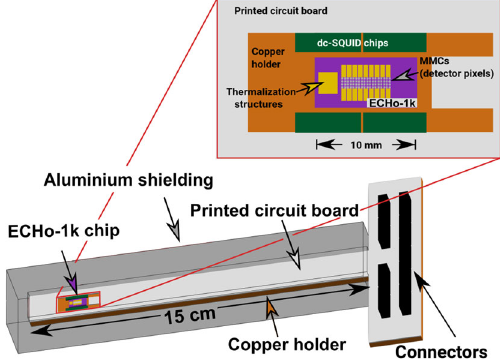
Fig. 2 Simplified design of the ECHo-1k experiment setup used in the simulation. Connectors are placed at a distance of about 15 cm from the ECHo-1k chip and an aluminum box surrounds the copper holder. On top of the copper holder, the white circuit board, the silicon substrate, with the ECHo detector pixels on top, and the dc-SQUID chips are placed. Insert: Magnification of the part close to the ECHo-1k chip. The purple colored silicon ECHo-1k chip is surrounded by four dc- SQUID chips (green). All chips are glued directly on the copper holder. On the ECHo-1k chip the large gold thermalization structured can be seen as well as the four rows of the MMCs (silver